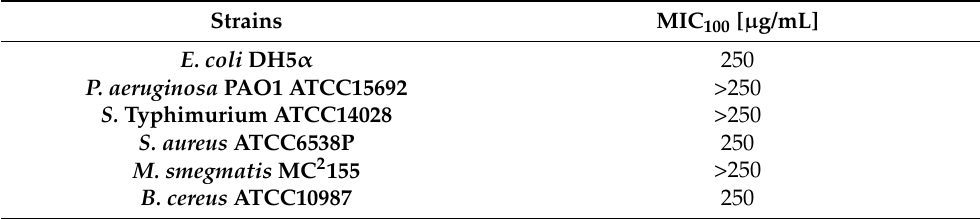
Table 1. Determination of the minimum inhibitory concentration values of bacterial growth (MIC 100 expressed as µ g/mL) of F. vulgare subsp. vulgare var. vulgare EO against Gram-negative and Gram- positive bacteria. The values were obtained from a minimum of three biological